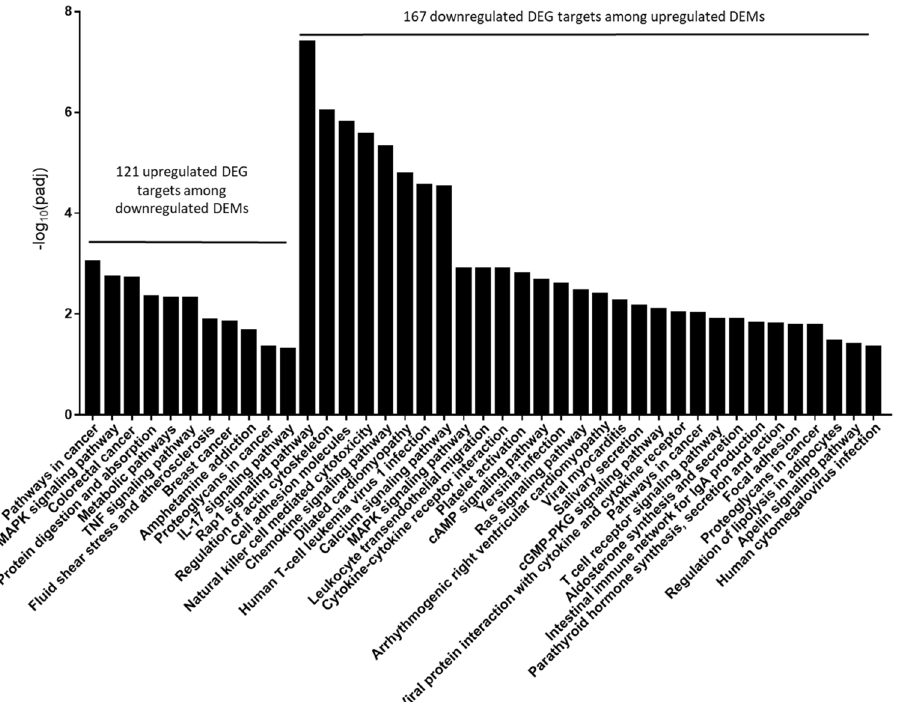
Figure 5. Pathway enrichment analysis using integrated analysis of differentially expressed miRNAs and gene targets with correlated expression changes. Validated and predicted gene targets for each identified DEM were collected from miRNet, TargetScan, and miRDB databases. Gene target lists were then integrated with gene expression data from mRNA sequencing. Gene targets with significantly upregulated expression were extracted for each downregulated DEM, while significantly downregulated gene targets were extracted for each upregulated DEM. The resulting upregulated and downregulated gene targets were compiled separately, and KEGG pathway enrichment analysis was performed using G:profiler with g:SCS multiple testing correction. All significantly enriched (padj < 0.05) pathways are shown in the bar graph